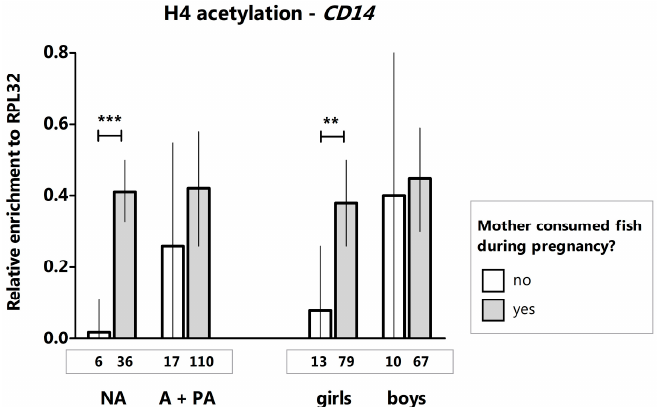
Figure 3. H4 histone acetylation levels (median with 95% confidence interval) at the CD14 promoter in placenta according to maternal fish consumption during pregnancy. NA denotes non-anthroposophic group; A, anthroposophic group; PA, partially anthroposophic group. Numbers of mothers with complete data on dietary exposures are presented below the bars. *** p < 0.0001, ** p < 0.01.